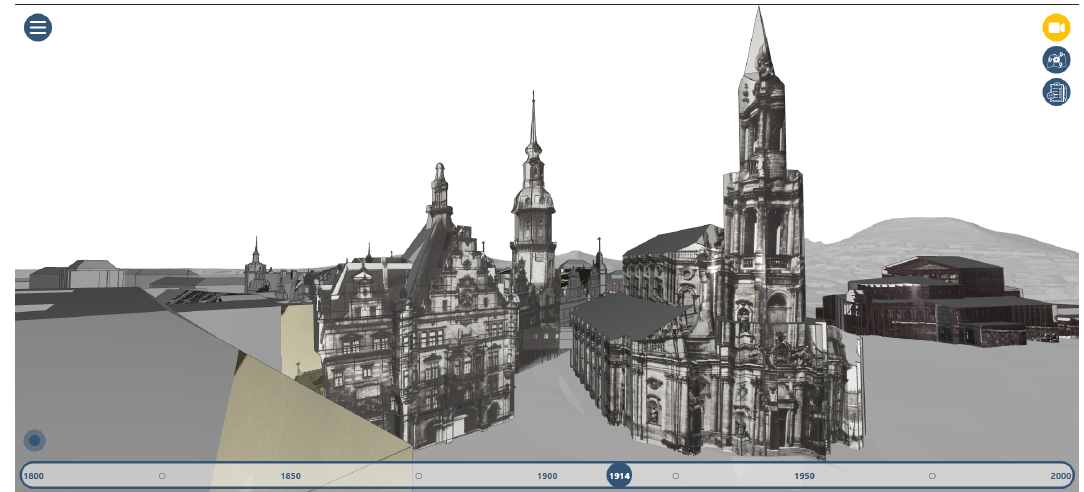
Figure 1. Example for projection of historical images on simple 3D models (under development) in application VR City https://4dcity.org/, accessed on 20 September